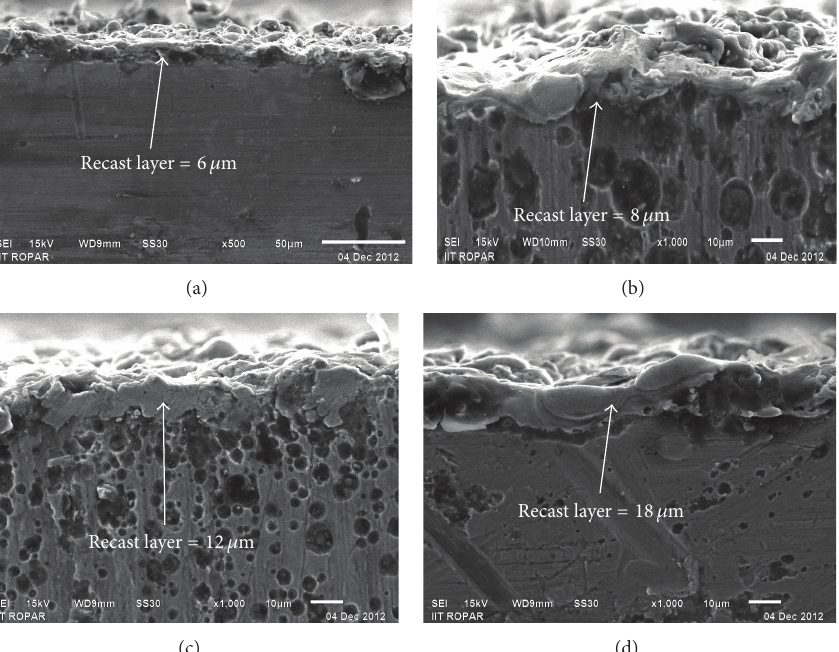
Figure 8: SEM micrographs of recast layer at various pulse on time and peak current: (a) 𝑇 on = 1.1 𝜇 s, Ip = 160A, (b) 𝑇 on = 1.1 𝜇 s, Ip = 200A, (c) 𝑇 on = 0.9 𝜇 s, Ip = 120A, (d) 𝑇 on = 0.9 𝜇 s, Ip =